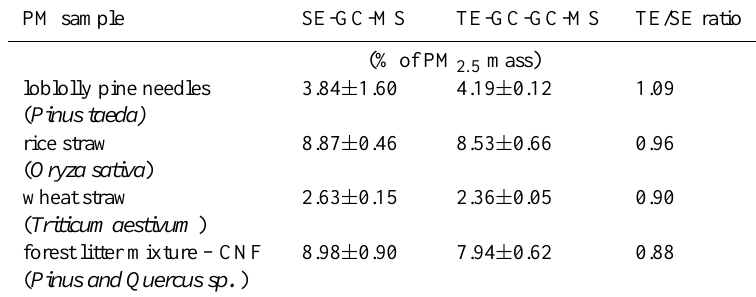
Table 2. Comparison of LG concentrations in biomass burning aerosols analyzed with SE-GC-MS and TE-GC-GC-MS methods (see Fig. 3). Shown are the mean and standard deviation based on triplicate analyses.